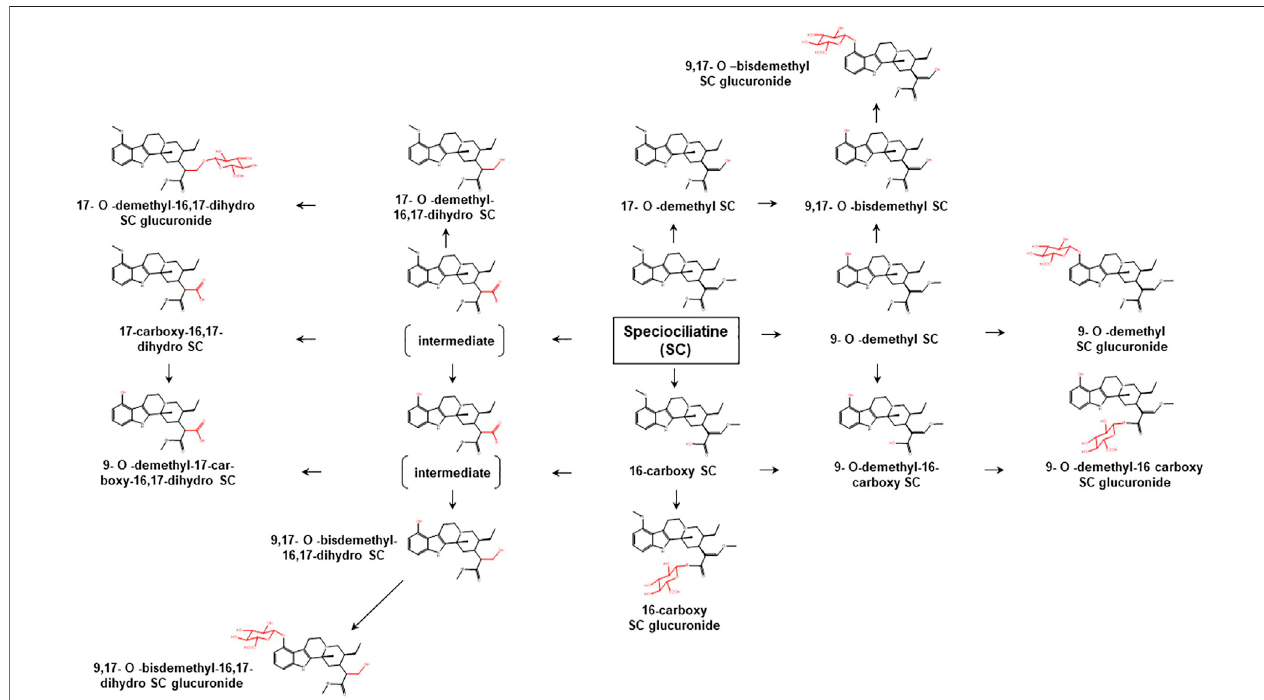
FIGURE 5 | Proposed metabolic pathways of SC based on data obtained in rodents and humans. Structures highlighted in red denote structural transformation from parent molecule SC. Figure was modi fi ed from Philipp et al. (2011a).